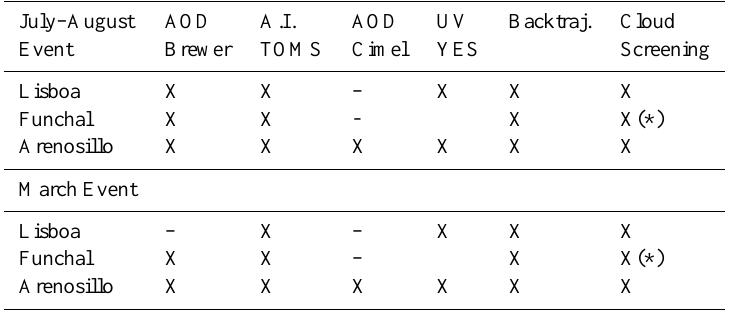
Table 1. Available measurements (X) in each station for the two considered desert dust events. Columns are from left to right: AOD from Brewer, TOMS aerosol index, AOD from Cimel, effective UV irradiance, back trajectories computation and cloud screening using UV measurements and Meteosat data. X(*) denote only Meteosat